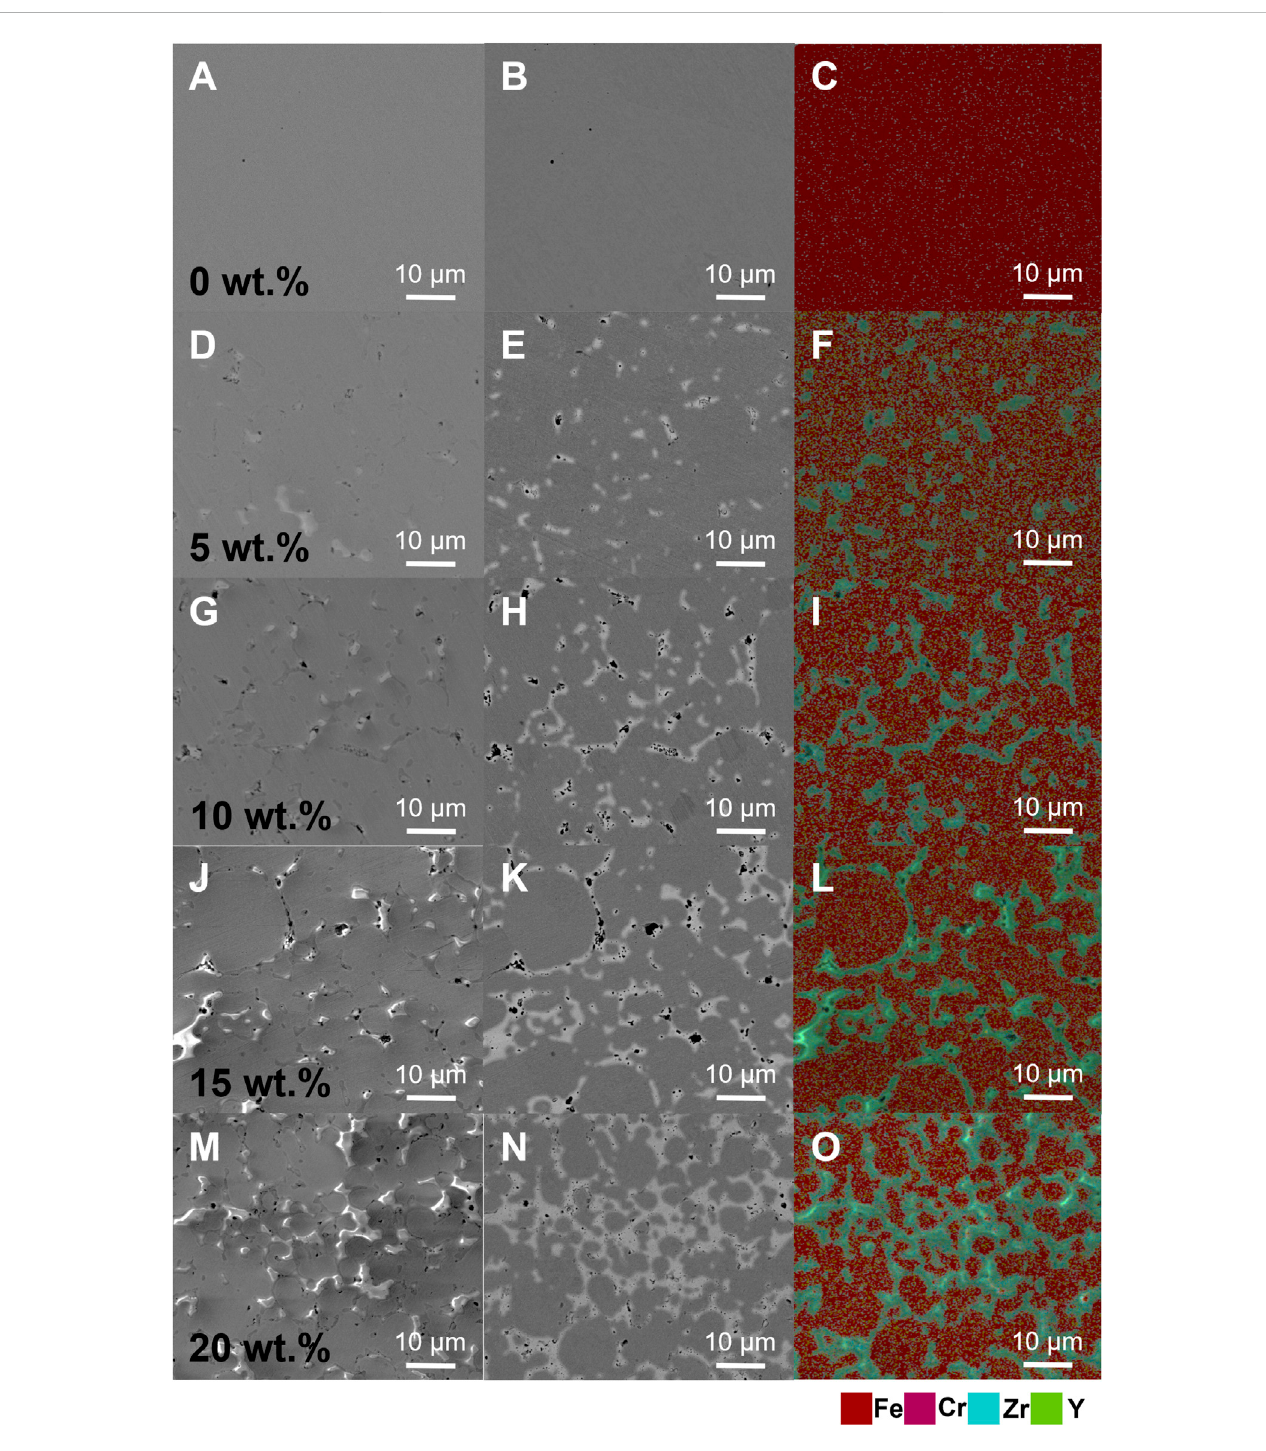
FIGURE 7 Cross sections of SS430L/YSZ samples with varying YSZ contents: SEM images (A, D, G, J, and M) ; BSE images (B, E, H, K, and N) ; and the energy dispersion spectrum (C, F, I, L, and O) .